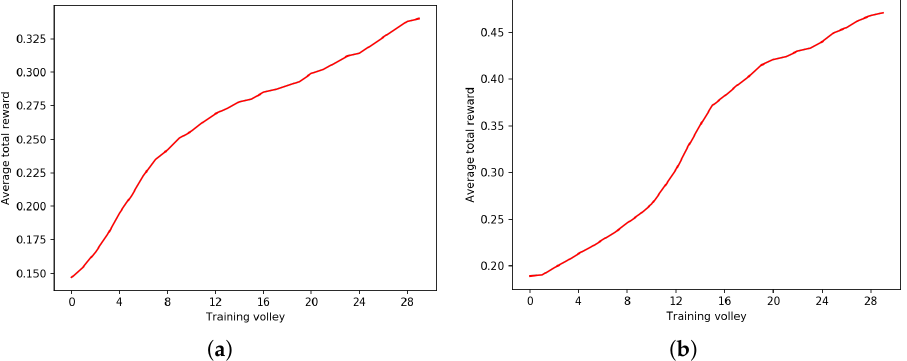
Figure 2. Experiment on BF with B = 80. The learning curve is different and the average total reward is better with ˆ π BF . Volleys are composed of 1000 episodes each, and the fixed length of each trajectory is T = 40 steps. ( a ) π BF with B = 80. ( b ) ˆ π BF with B = 80.